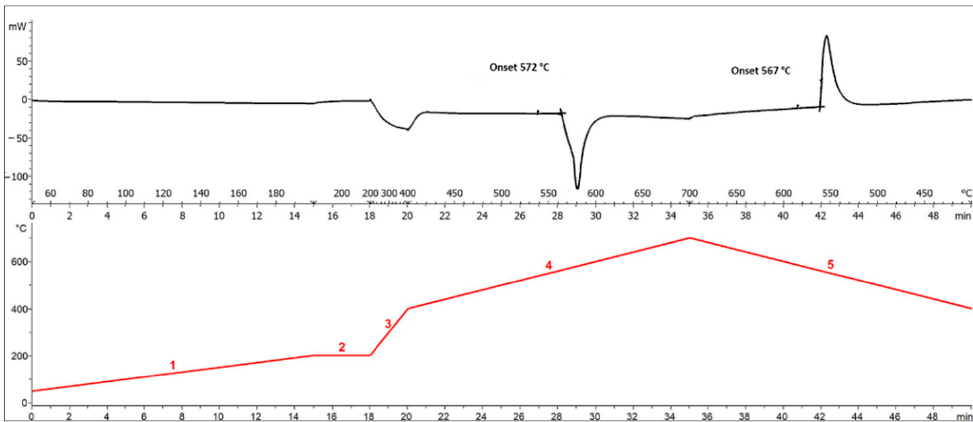
Figure 3. TGA/DSC analysis to determine liquidus and solidus temperatures of the ternary eutectic used as PCM. The figure shows, on the top, the heat flow with the onset temperatures marked and, on the bottom, the temperature program applied. The test was carried out under a flow of 40 Nml/min of N 2 .